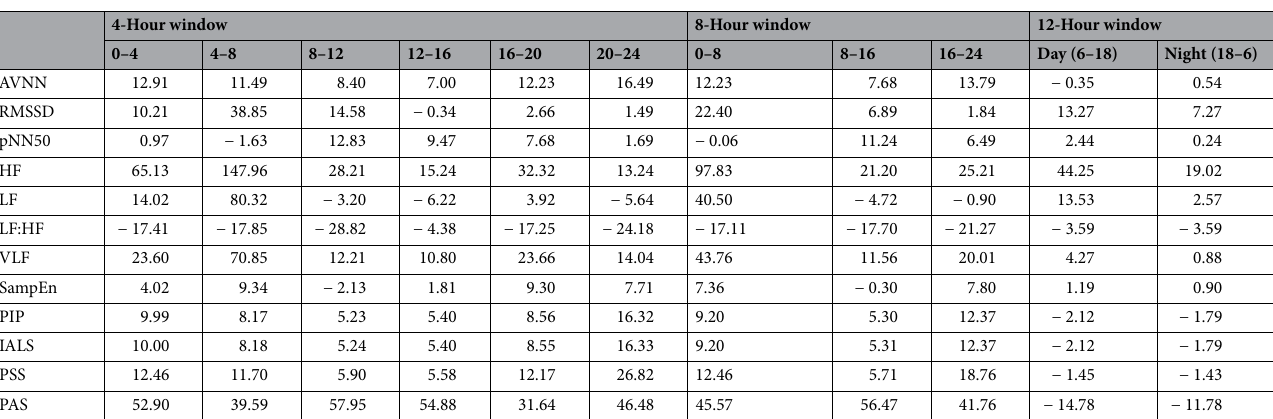
Table 2:. % ∆HRV RBB for 4-h, 8-h and 12-h window analysis for all HRV